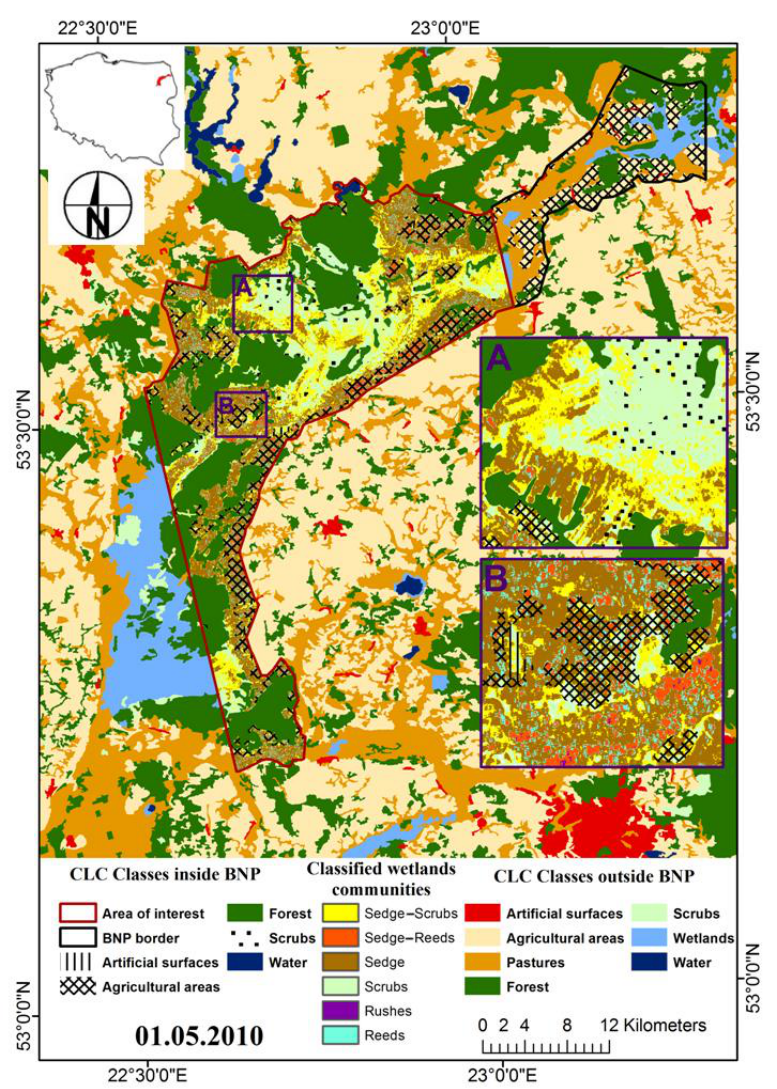
Figure 8. Map of wetland communities classified based on PALSAR HV image registered on 1 May 2010, placed on CLC